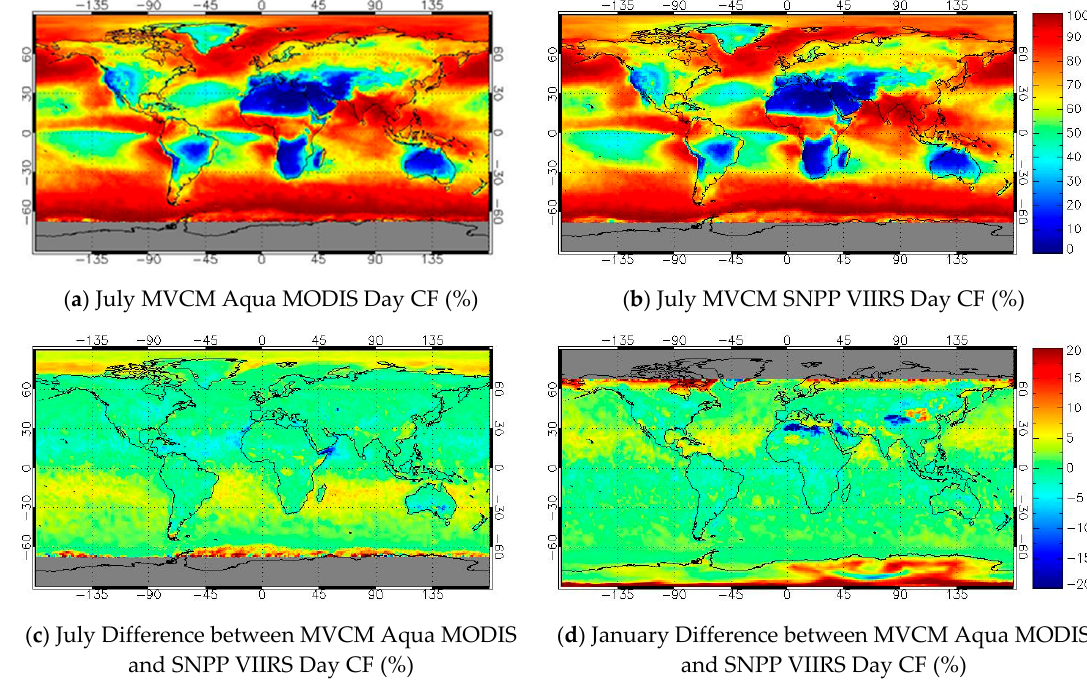
Figure 2. MVCM cloud fractions (CFs) and differences from January and July 2013–2019; ( a ) monthly mean daytime MVCM Aqua MODIS CFs for July; ( b ) monthly mean daytime MVCM SNPP VIIRS CFs for July; ( c ) daytime July CF differences between MVCM Aqua MODIS and MVCM SNPP VIIRS; ( d ) daytime January CF differences between MVCM Aqua MODIS and MVCM SNPP VIIRS.